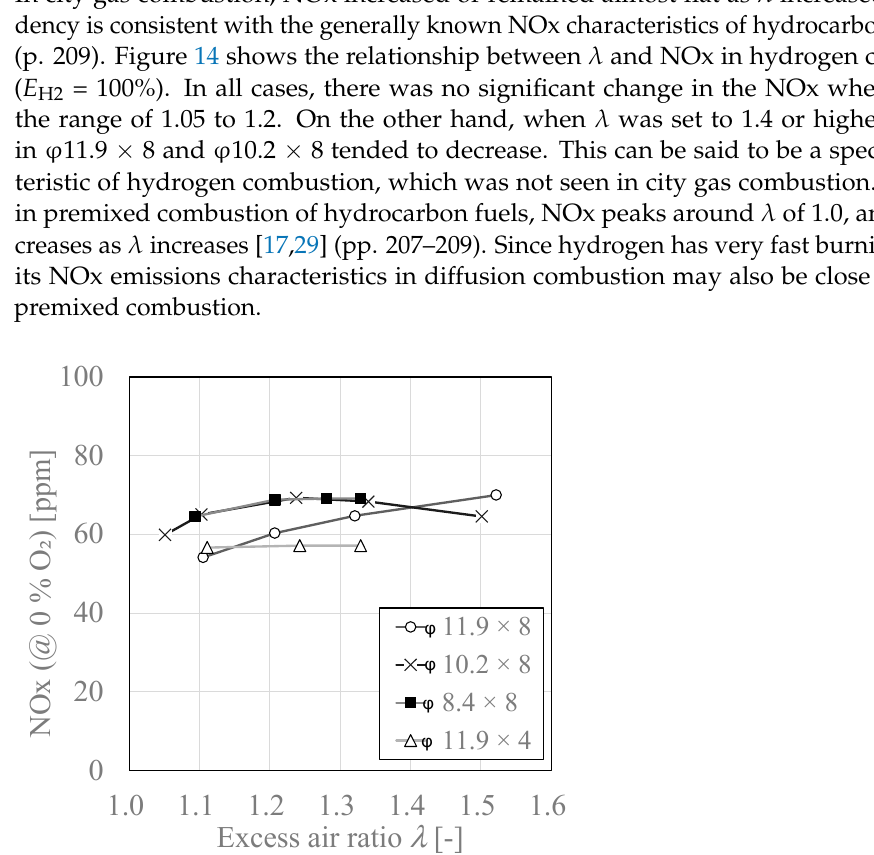
Figure 13. NOx for different λ under each air nozzle case, at 1273 K and E H2 = 0%. Input = 174 kW, P = +15 Pa .